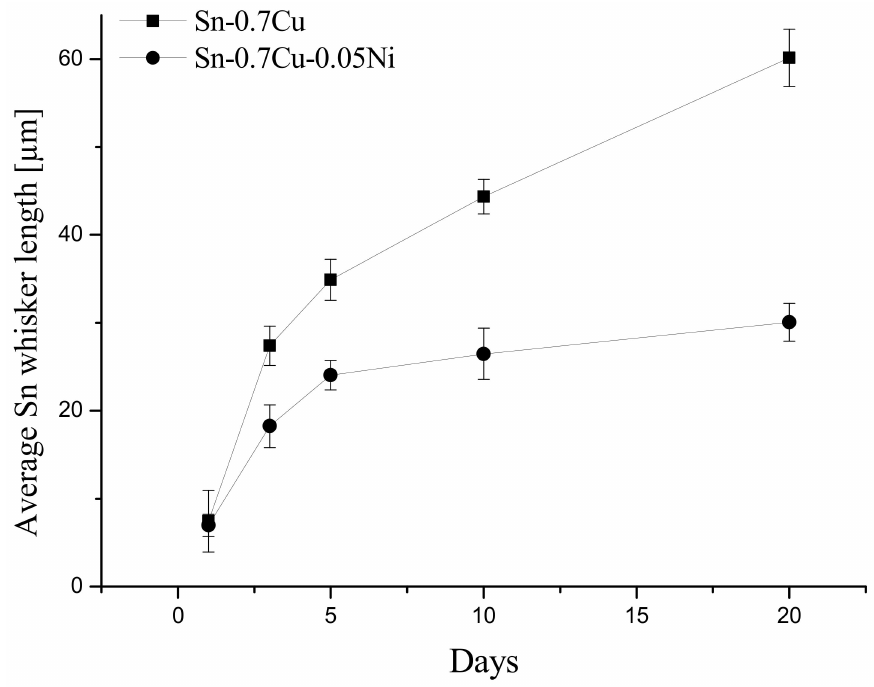
Figure 5. The average length of Sn whiskers in Sn-0.7Cu and Sn-0.7Cu-0.05Ni solder joints.